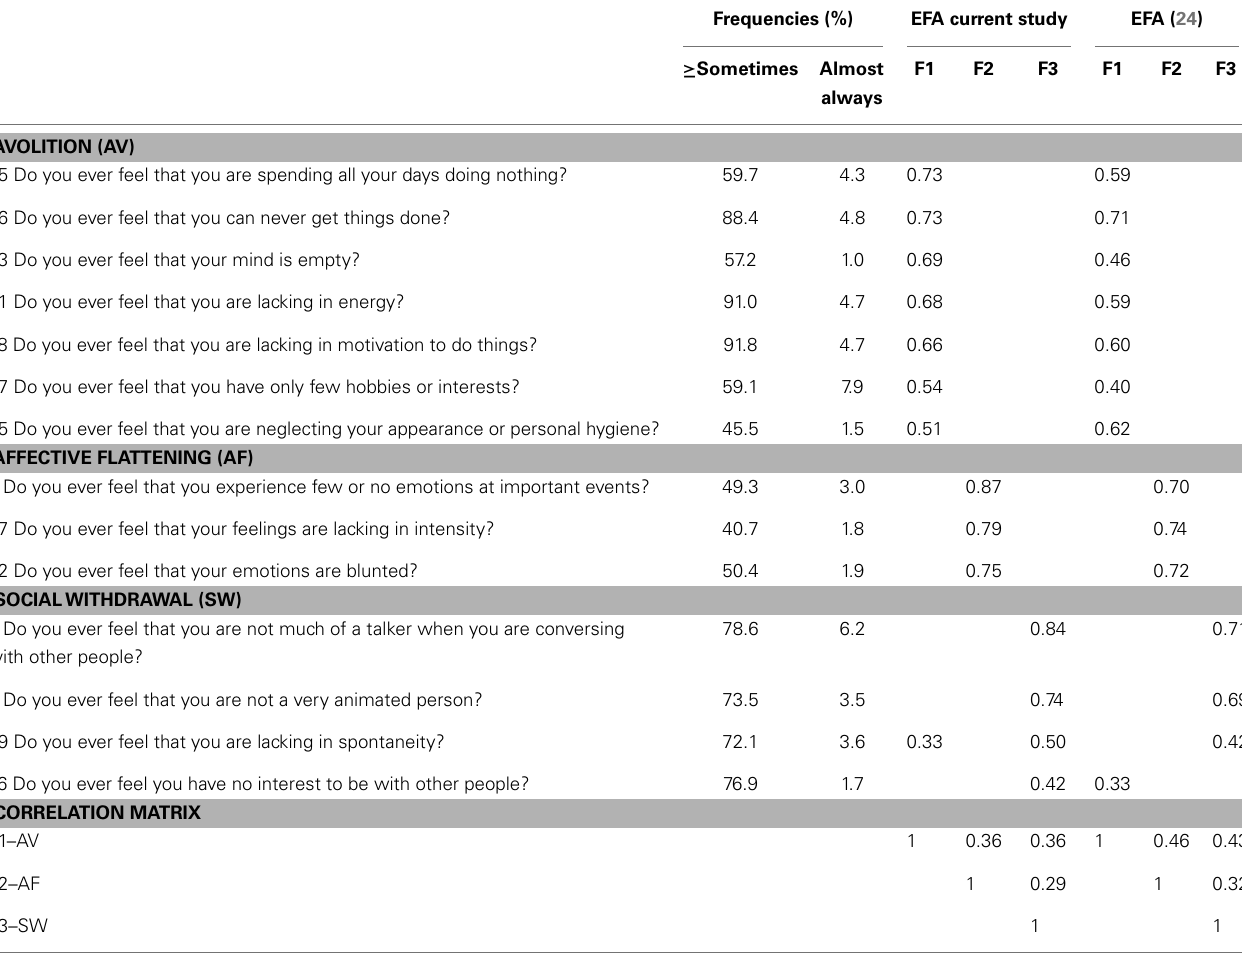
Table 3 | Community assessment of psychic experiences: negative symptoms frequency scores and factor analysis